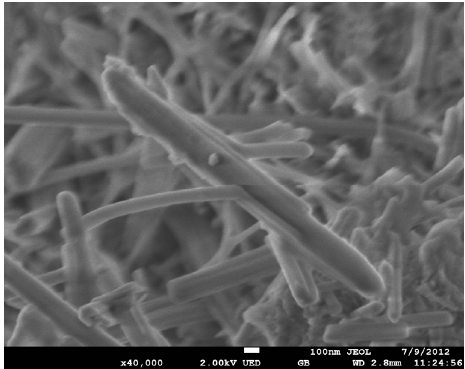
Figure 3: Image FESEM of cement mixed with 12% additive.